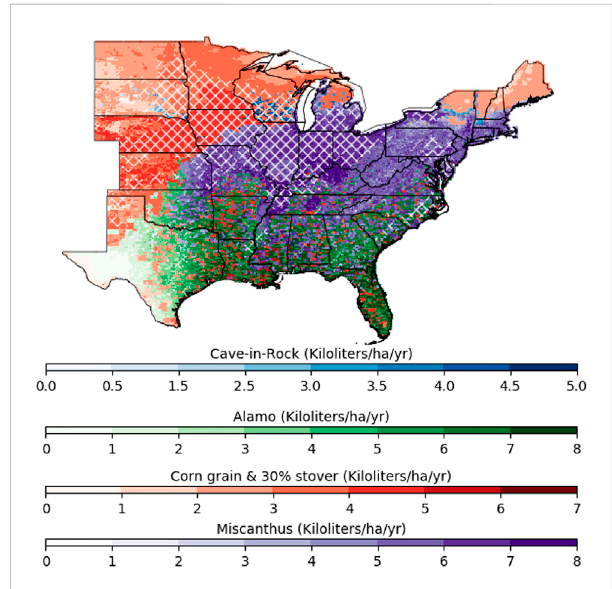
FIGURE 3 The distribution of maximum potential bioethanol yield across the modeled crops: Miscanthus, two switchgrass cultivars, upland (Cave-in-Rock) and lowland (Alamo), and corn (grains plus 30% stover harvested). The fi gure shows only the yield for crop or crop cultivar studied here. The current major corn growing area (i.e., the harvested area where corn is grown on over 500 ha in white) (See Supplementary Figure S2) overlays some of the highest-yielding land